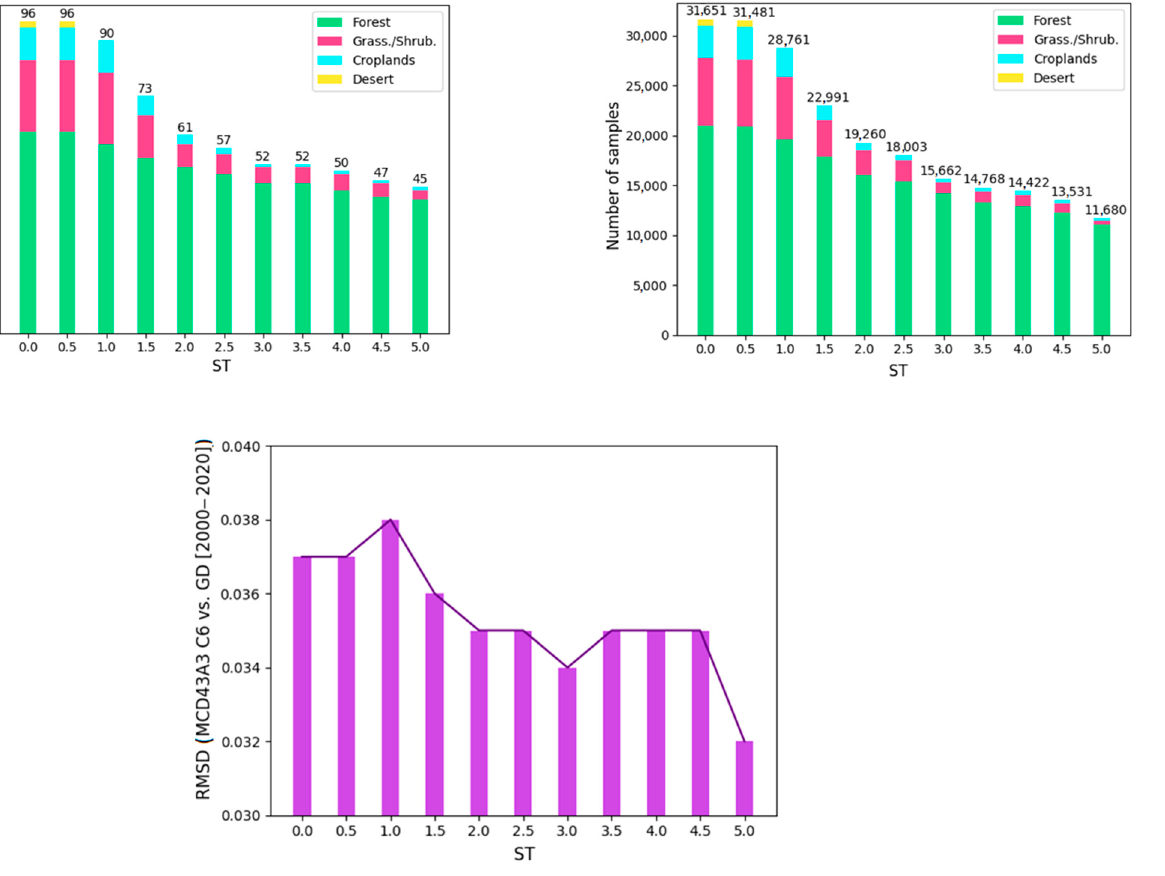
Figure 3. Evolution of Number of sites ( top left ), Number of samples ( top right ), and RMSD ( bottom ) of the comparison of MCD43A3 C6.1 versus REALS sites as a function of the ST score in the 2000–2020 period.